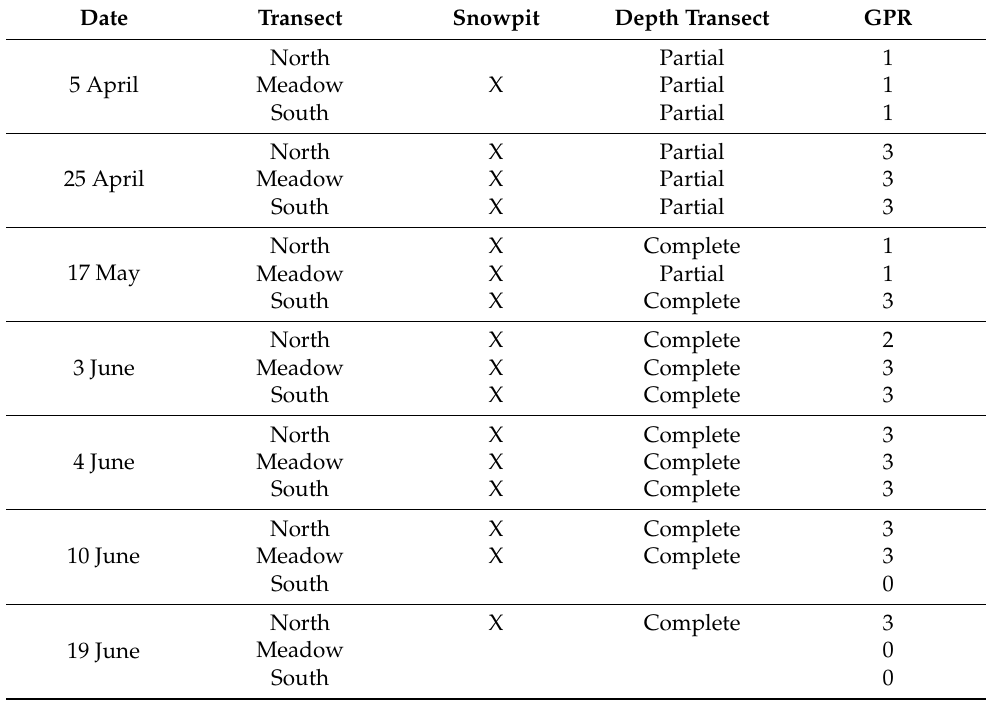
Table 1. Observations performed for each survey date. Depth transects were collected once per survey date and were acquired as either a complete transect or a partial transect. GPR transects were performed up to three times per survey